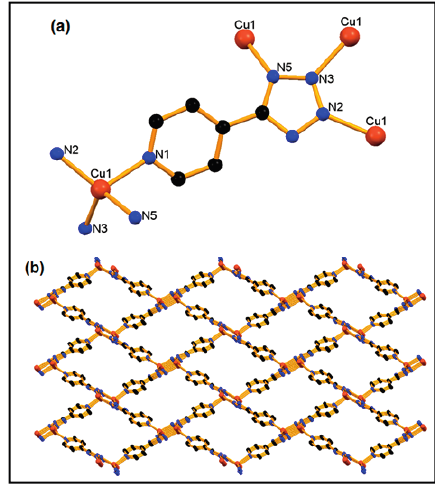
Figure 2. Structural fragments of 1 representing ( a ) the basic unit; ( b ) a view of rhomboid voids along the a -axis. Color codes: Cu brown, C black, and N